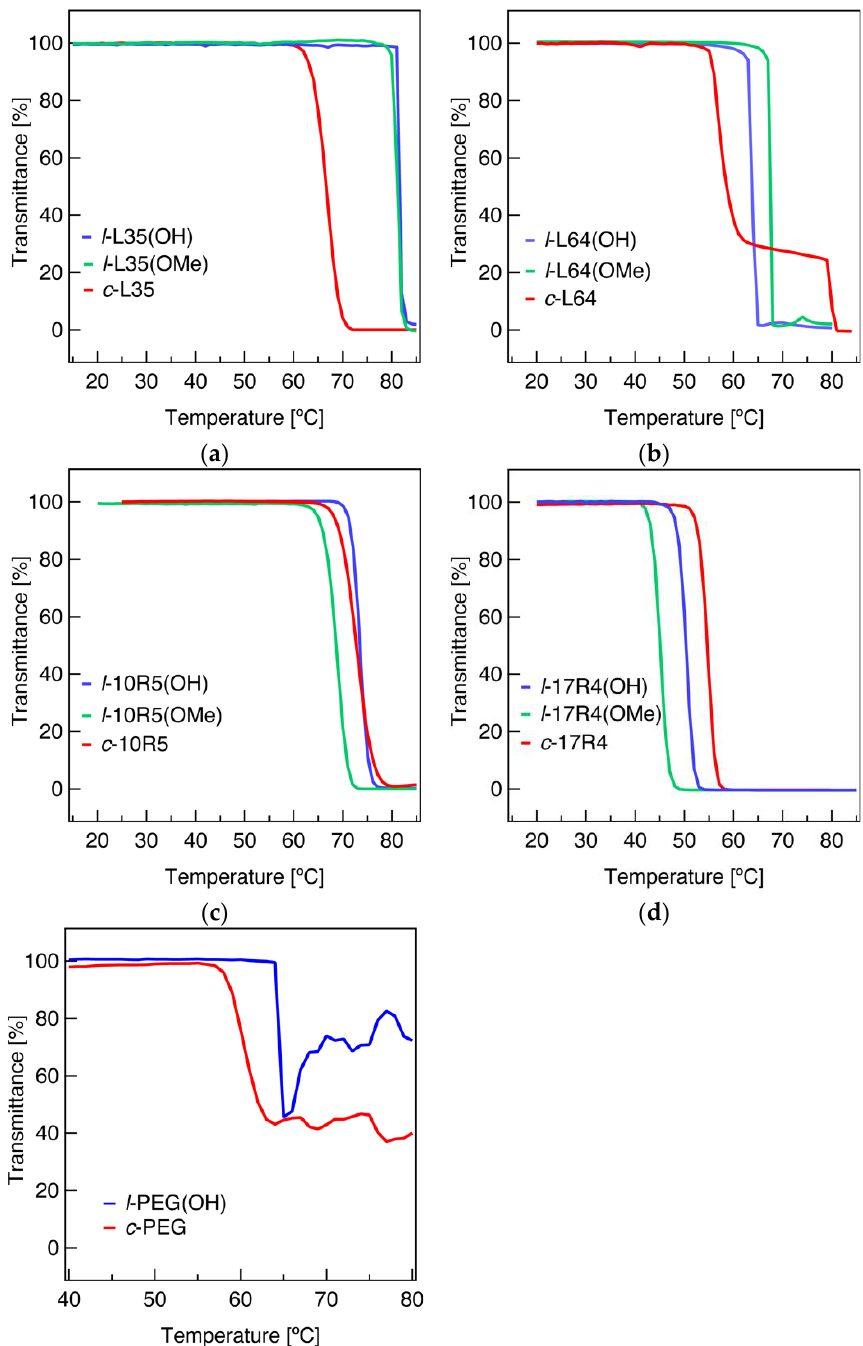
Figure 3. ( a ) Temperature-dependent transmittance (%T) at 600 nm for 10 g/L aqueous solutions of linear hydroxy-terminated (blue), methoxy-terminated (green), and cyclized (red) L35, indicated as l -L35(OH) , l -L35(OMe), and c -L35 , respectively. Those of ( b ) L64, ( c ) 10R5 and ( d ) 17R4 are also shown. ( e ) %T at 600 nm for 10 g/L linear hydroxy-terminated (blue) and cyclized (red) PEG homopolymers in aqueous NaH 2 PO 4 solutions at the concentration of 250 g/L.